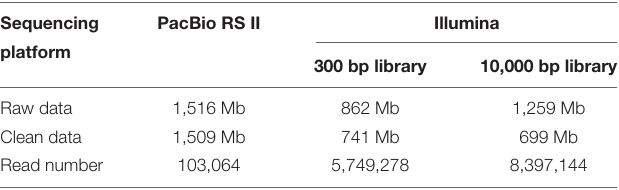
TABLE 1 | Summary of the sequencing data obtained with PacBio and Illumina technology and used for the genome assembly of C. oleophila I-182.